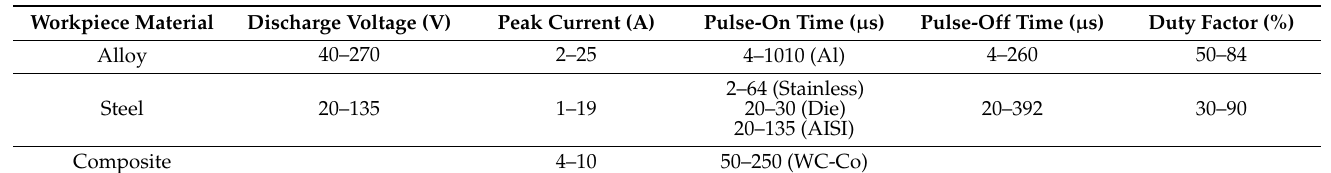
Table 20. Range of voltage, current, pulse-on and pulse-off times and duty factor for various materials in EDC by powder metallurgical electrode method